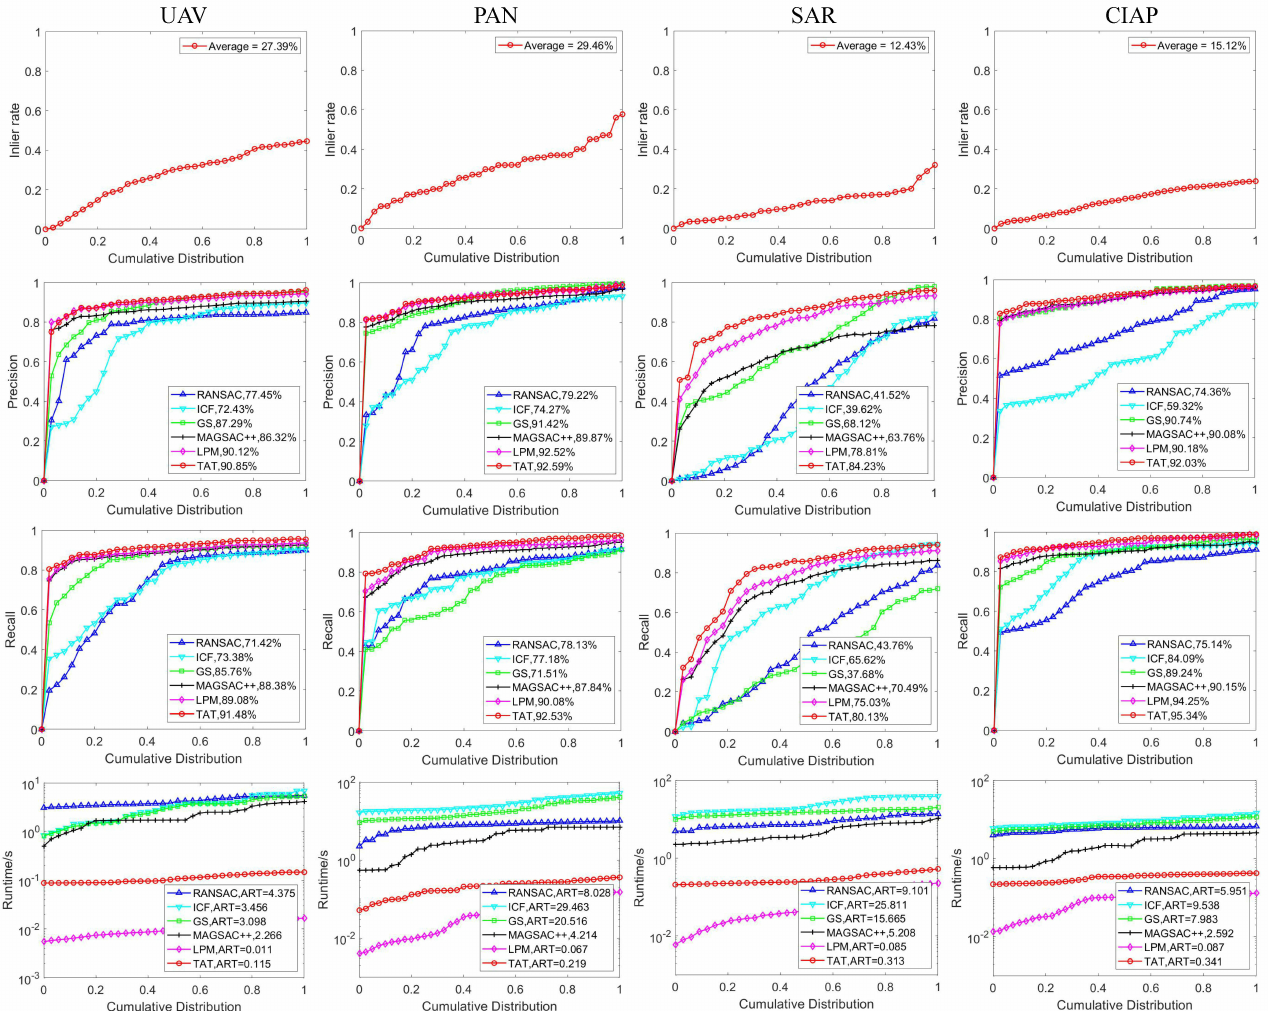
Figure 8. Quantitative comparisons of RANSAC [13], ICF [40], GS [47], MAGSAC++ [48] LPM [16], and TAT on four test datasets, such as UAV, PAN, SAR, and CIAP. ( Top – Bottom ) Initial inlier ratio, precision, recall, and run time with respect to the cumulative